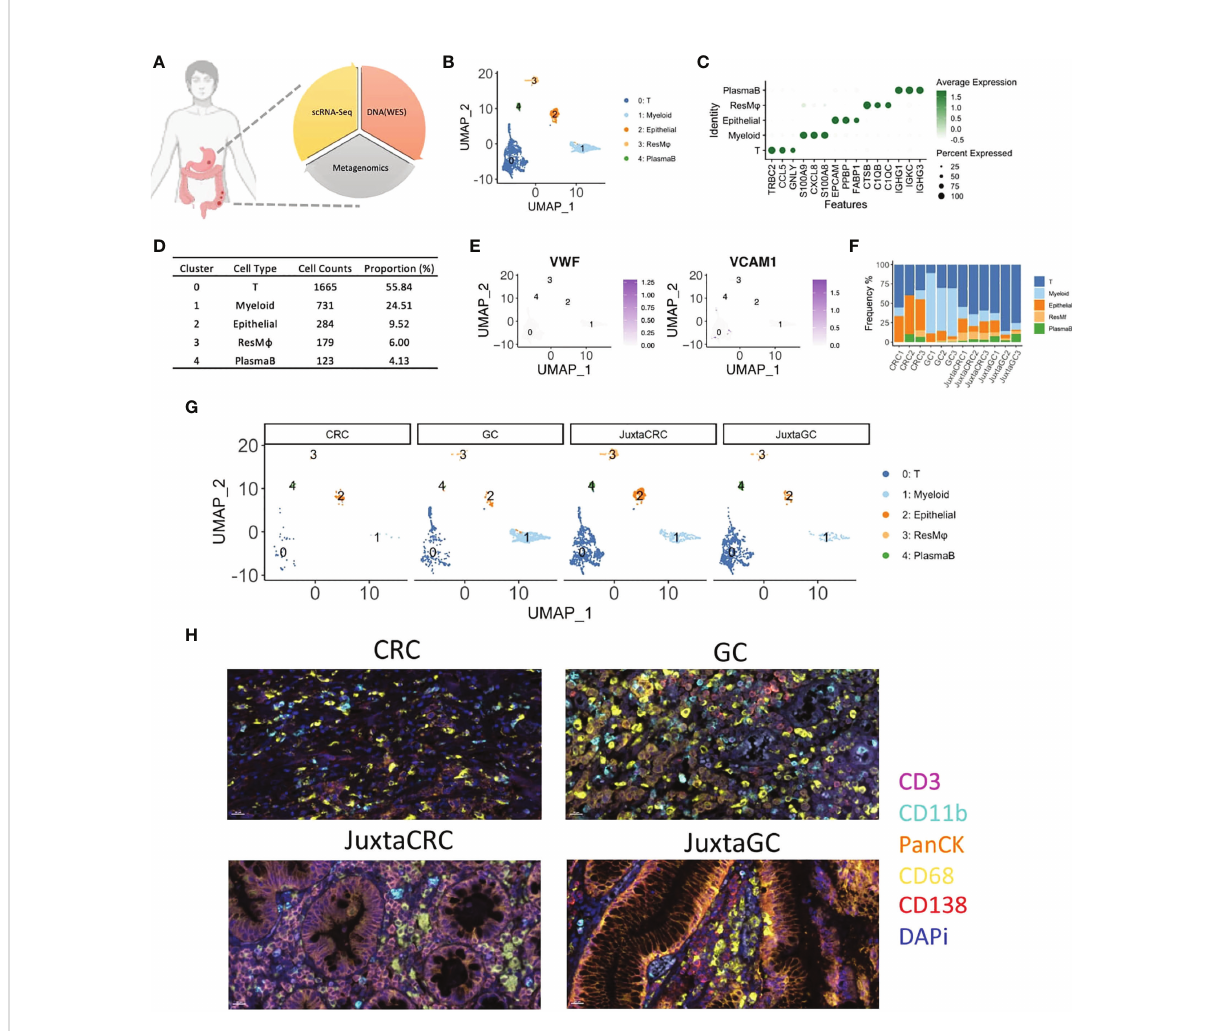
FIGURE 1 The overview of scRNA-seq pro fi les of CRC and GC. (A) The schematic of experimental design in this study. ScRNA-seq, WES, and OTU investigated the primal malignancy sites ’ transcriptomics, genomics, and metagenomics pro fi le. (B) UMAP plot of scRNA-seq data identi fi ed fi ve cell populations, including T cells, myeloid cells, epithelial cells, residential macrophages (ResM j ), and plasma B cells. (C) Dot plot showed the top 3 cluster-speci fi c feature genes, dot size indicated the percent expressed, and the level of color indicated the average expression. (D) The distribution frequency and proportion of each cell population. (E) Feature plots showed the expression pattern of the diagnostic marker genes for endothelial cells, including VWF and VCAM1. (F) Bar plot displayed the proportion of each cell population across samples. (G) UMAP plots of scRNA-seq data spat by samples. (H) mIHC staining of CD3 (magenta), CD11b (cyan), PanCK (orange), CD68 (yellow), CD138 (red), and DAPi (blue) in CRC, GC, JuxtaCRC, and JuxtaGC